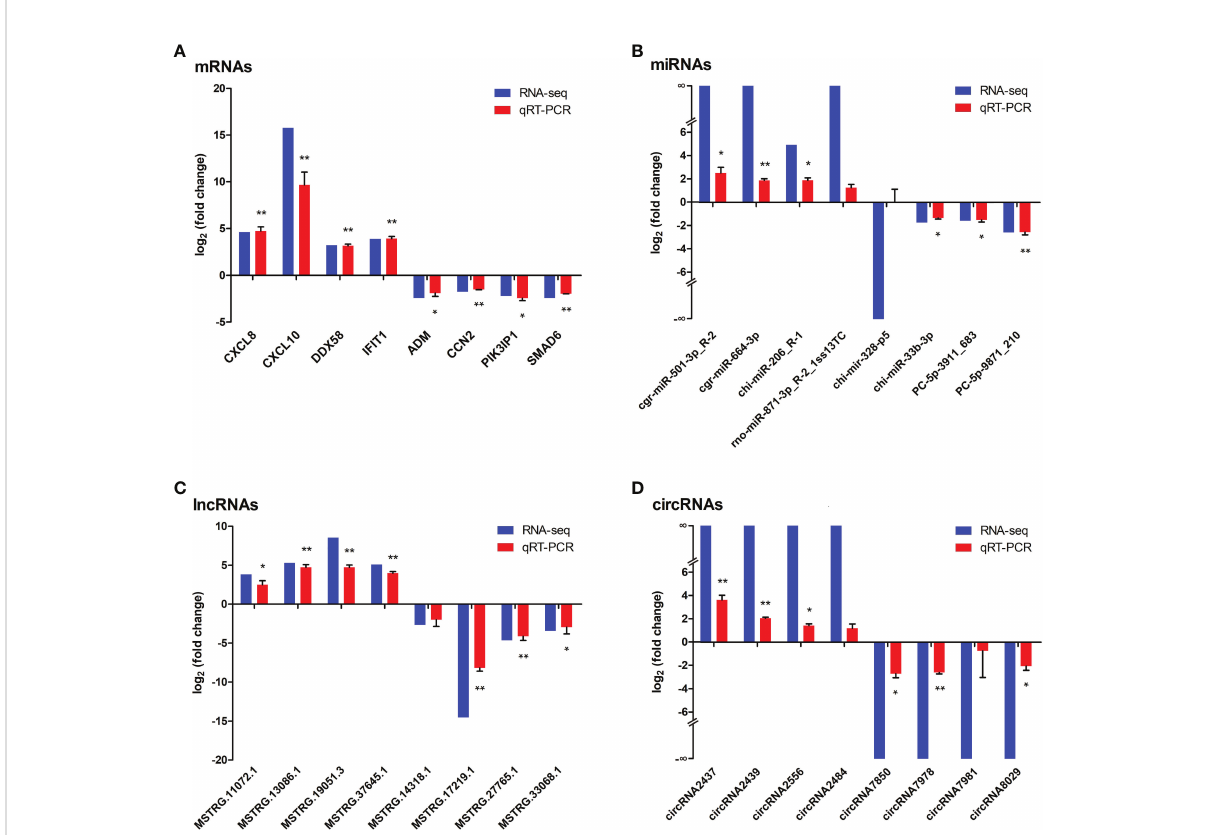
FIGURE 10 Veri fi cation the expressions of (A) dif-mRNAs, (B) dif-miRNAs, (C) dif-lncRNAs, and (D) dif-circRNAs using qRT-PCR, respectively. Blue and red bars represented the whole transcription sequencing results and qRT-PCR validation results respectively, whereas qRT-PCR validation results were displayed as mean log 2 (fold change) ± SD with error bars from three independent experiments. Symbols * and ** indicated the difference between the indicated groups was signi fi cant ( p -value < 0.05) or very signi fi cant ( p -value < 0.01